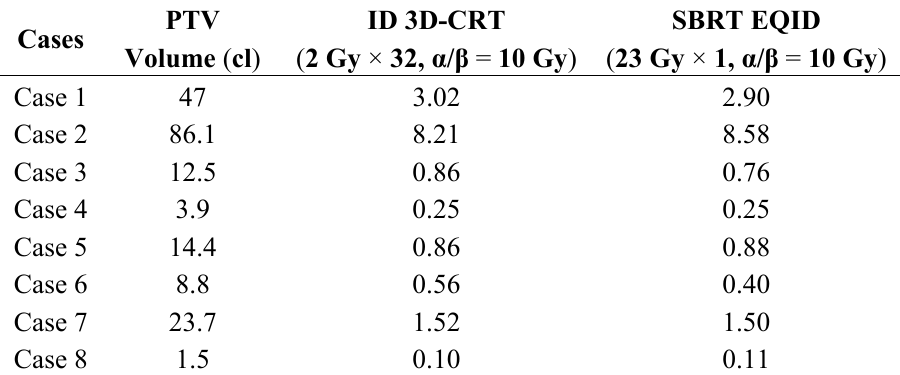
Table 4. PTVs integral dose (Gy × liter). As expected, no significant difference of ID to PTVs were observed ( p =